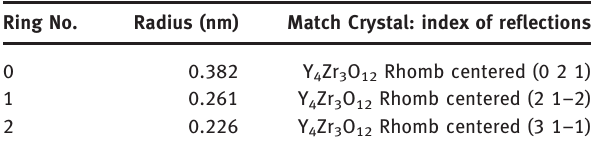
Table 2: Radius of rings from SAD pattern and possible matches for Zr-ODS steel [27]. Ring No. Radius (nm) Match Crystal: index of reflections